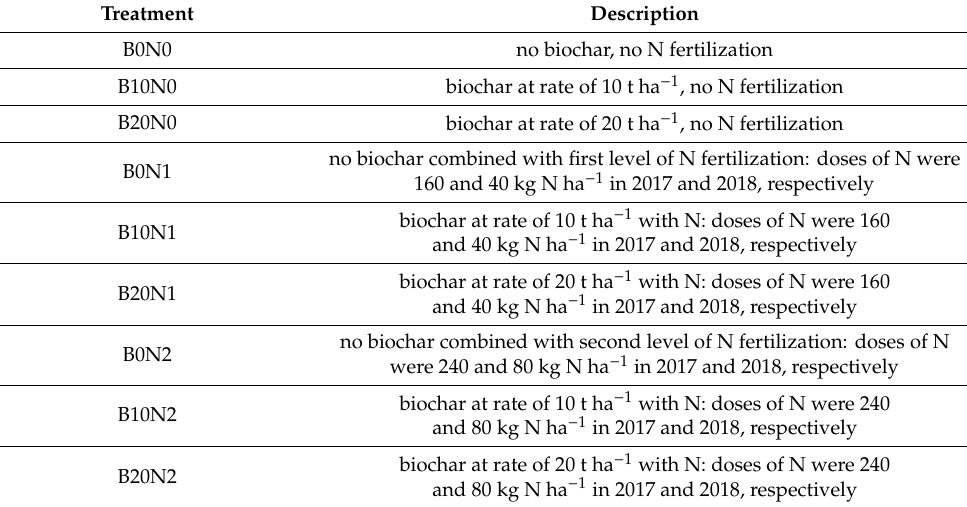
Table 2. List of investigated treatments and overview of individual amounts of applied biochar and inorganic fertilizer of the field